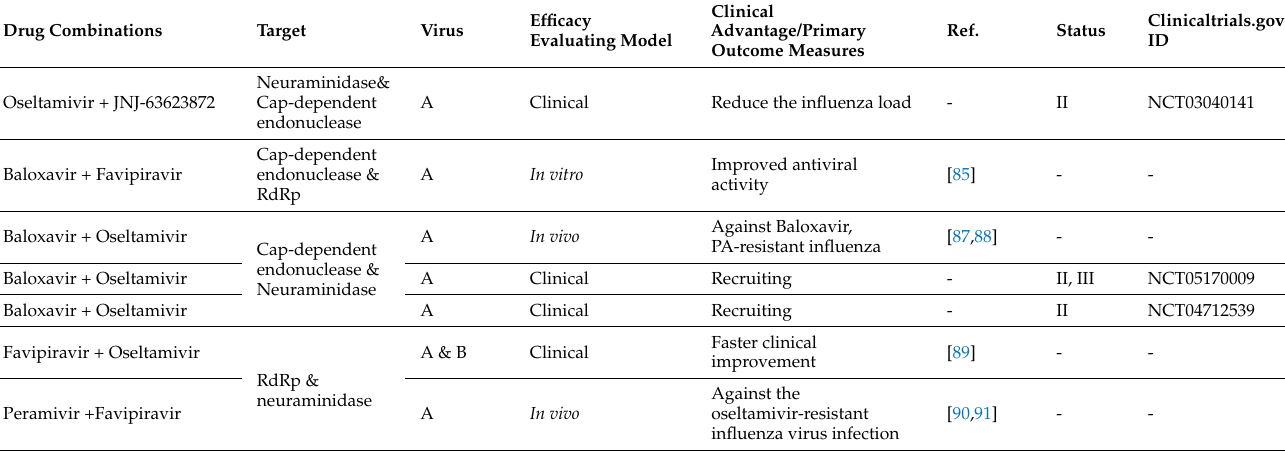
Table 4. Antivirals combination therapy target two or more proteins of the influenza